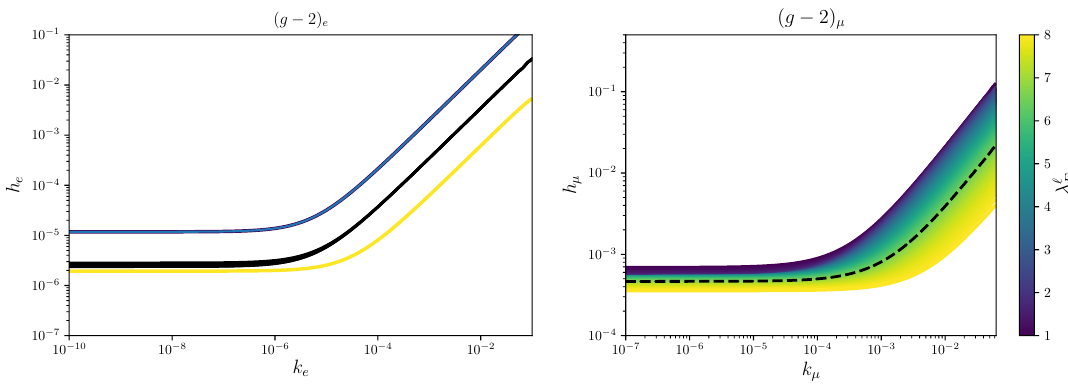
Figure 5 . Viable regions in h ‘ vs. k ‘ parameter space: on the left (right) ‘ = e ( (cid:22) )). In both panels the colour code denotes the value of (cid:21) ‘ ( (cid:21) E = 1 (cid:0) 8, from dark violet to yellow). On the left panel, E only the central black line complies with ( g (cid:0) 2) e at the 2 (cid:27) level (i.e. (cid:21) e (cid:24) 6 : 4); for the right panel, E all the coloured region allows to satisfy ( g (cid:0) 2) (cid:22) at 2 (cid:27) (the dashed black line illustrates the value (cid:21) (cid:22) (cid:24) 6 : 4). All other relevant parameters (cid:12)xed as leading to (cid:12)gure E